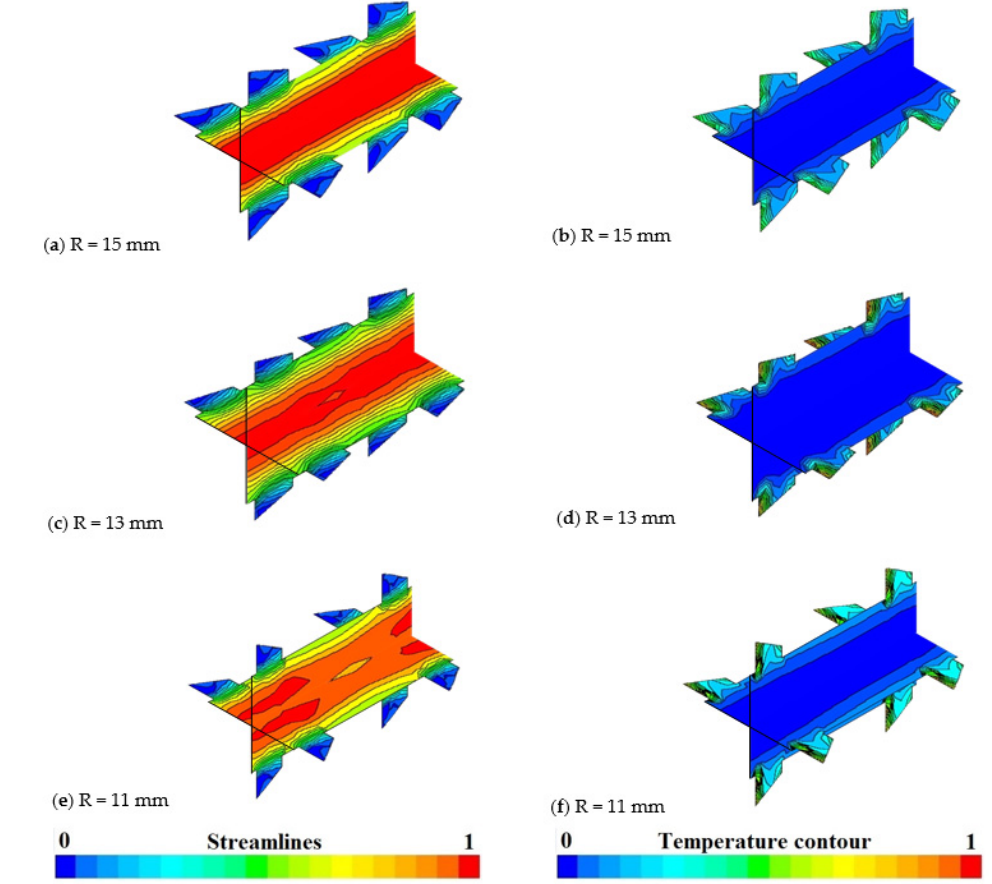
Figure 26. Streamlines and temperature contours for various configurations of Case E with different R parameters at E 2 = 24 mm, Re = 15,000, and ϕ =